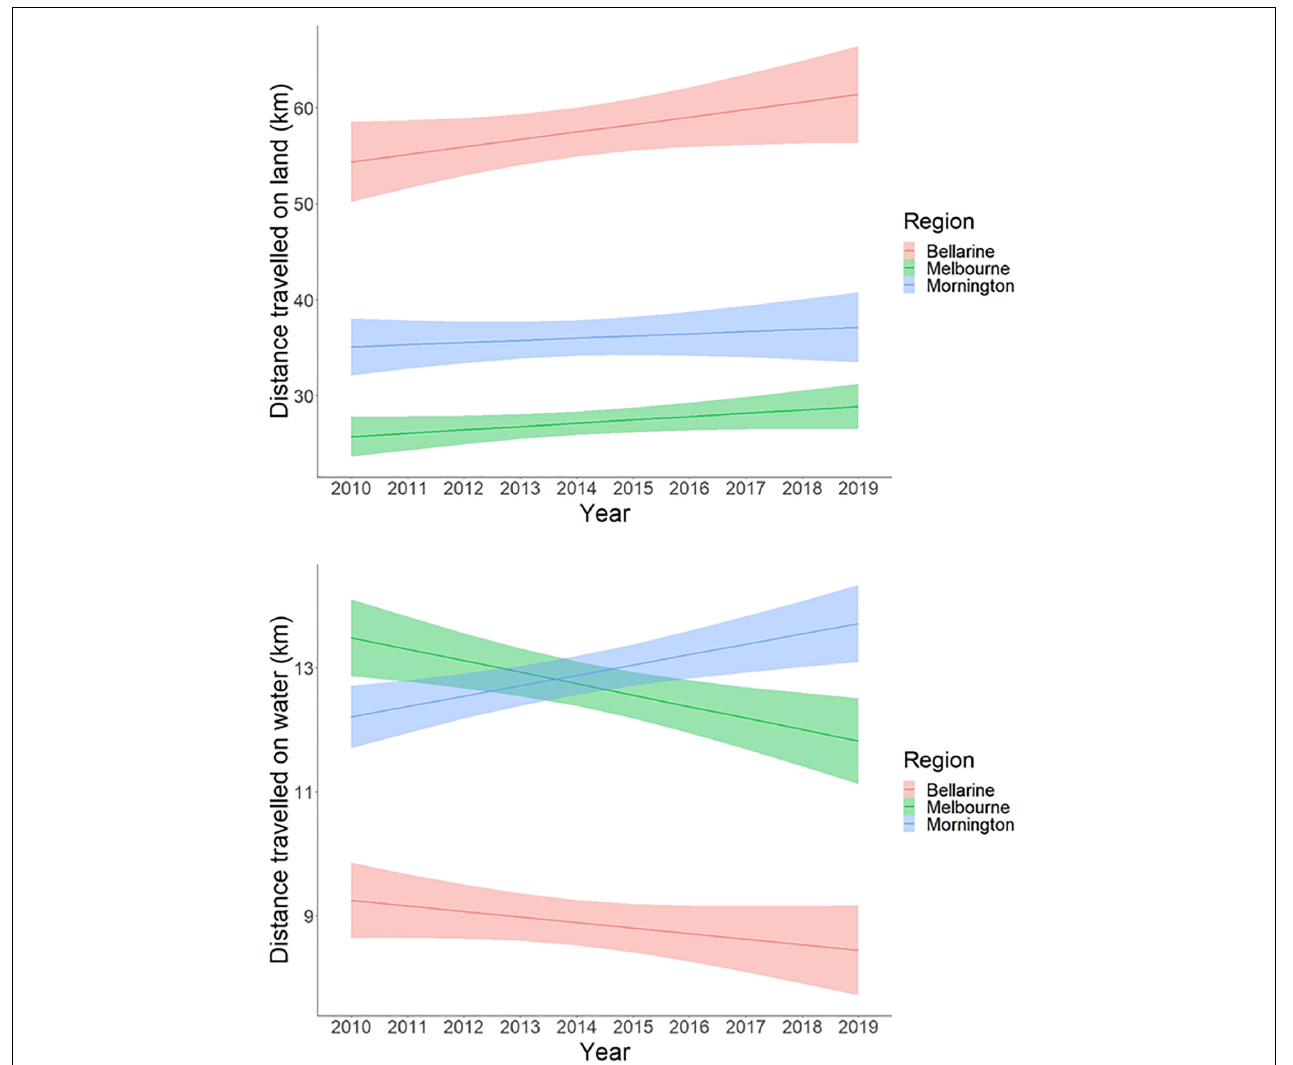
FIGURE 8 | GLM plots of temporal trends in the anglers’ average travel distance (km) on land and water by residential region, combined across species. Shaded areas represent the 95% confidence intervals.